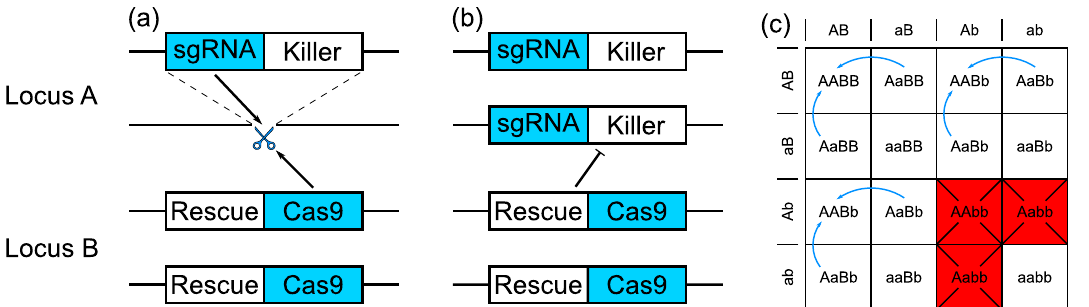
Figure 1. A schematic diagram of the split-drive killer-rescue (SDKR) mechanism of action. ( a ) When at low frequency the system primarily functions as a split CRISPR gene drive in that the Cas9 of construct B is directed to cleave the wild-type sequence at locus A by the sgRNA of construct A. This DSB is repaired using construct A as a template, resulting in an individual homozygous for construct A. ( b ) As construct A reaches higher frequencies, the lethal effector creates a selection pressure for individuals to also carry the rescue component from construct B, resulting in an increasing frequency of construct B. ( c ) A Punnett square demonstrating the mechanism of action of this system. Red squares indicate non-viable genotypes, i.e. those carrying lethal effectors but not the associated suppressors. Blue arrows indicate the effects of the split CRISPR drive components, turning transgene heterozygotes at locus A into transgene homozygotes.